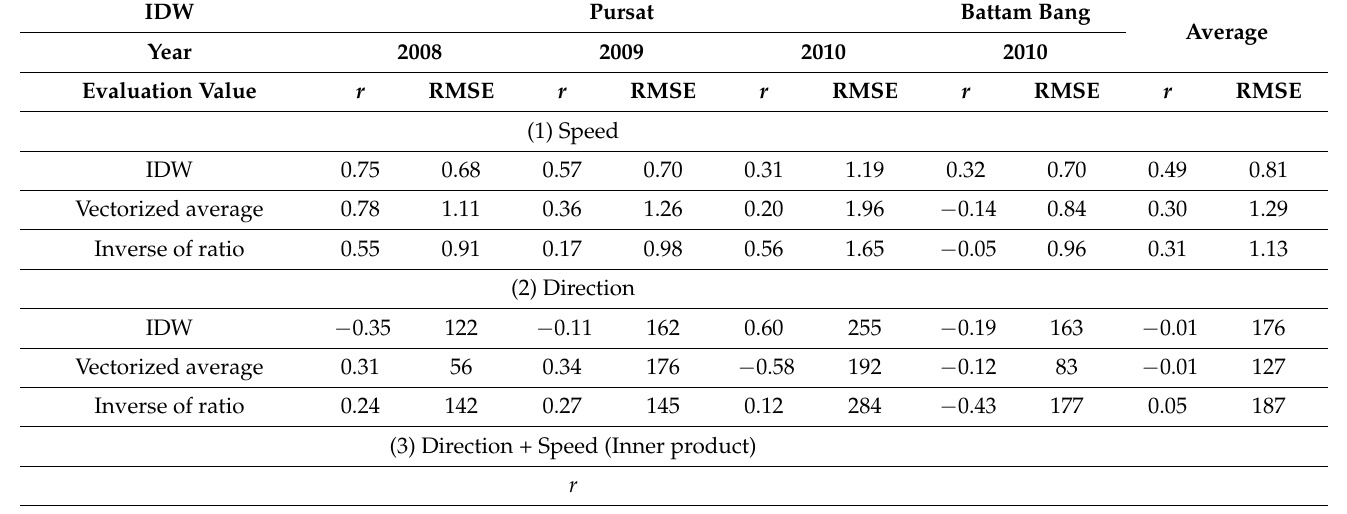
Table 1. Pearson correlation coefficient ( r ) and RMSE of interpolation for wind data.